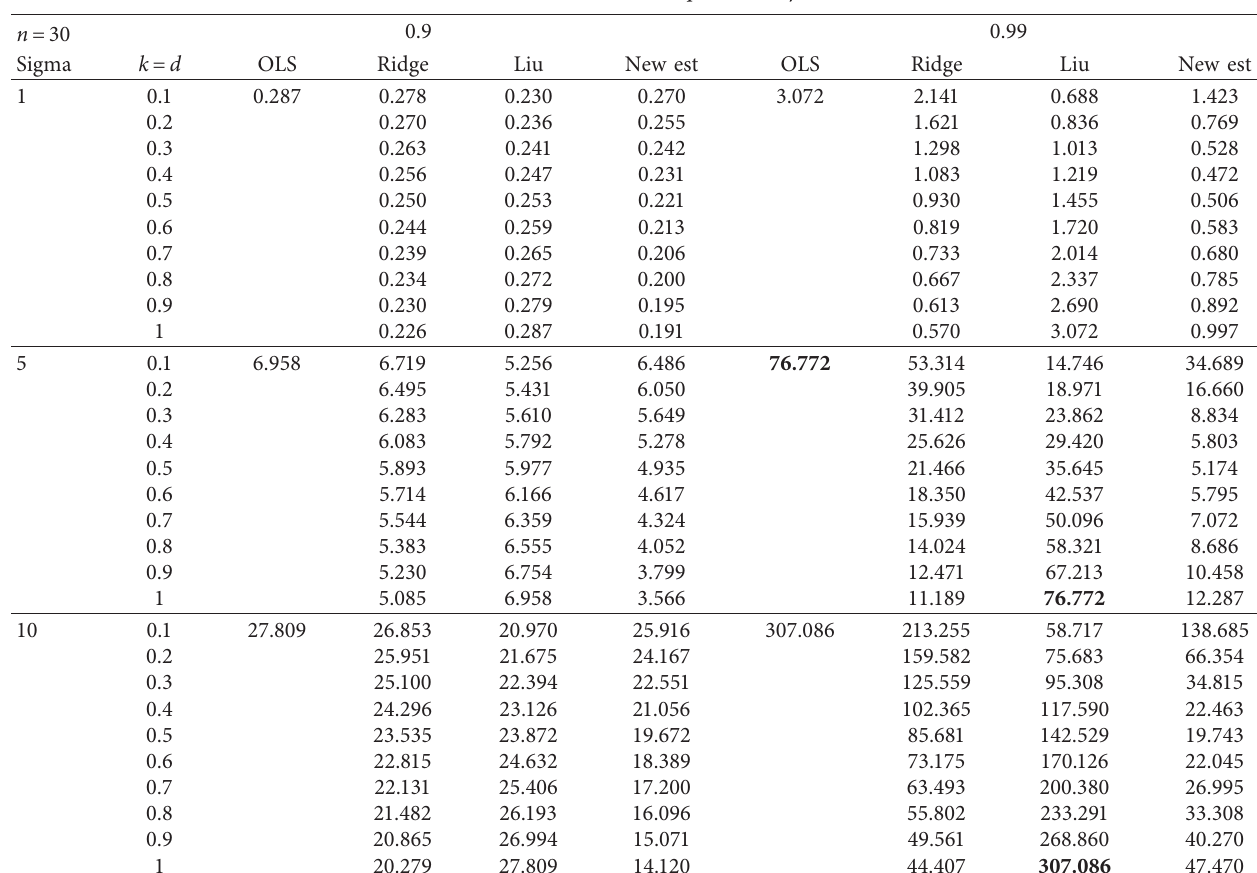
Table 4: Estimated MSE when n � 100, p � 3, and ρ � 0.90 and